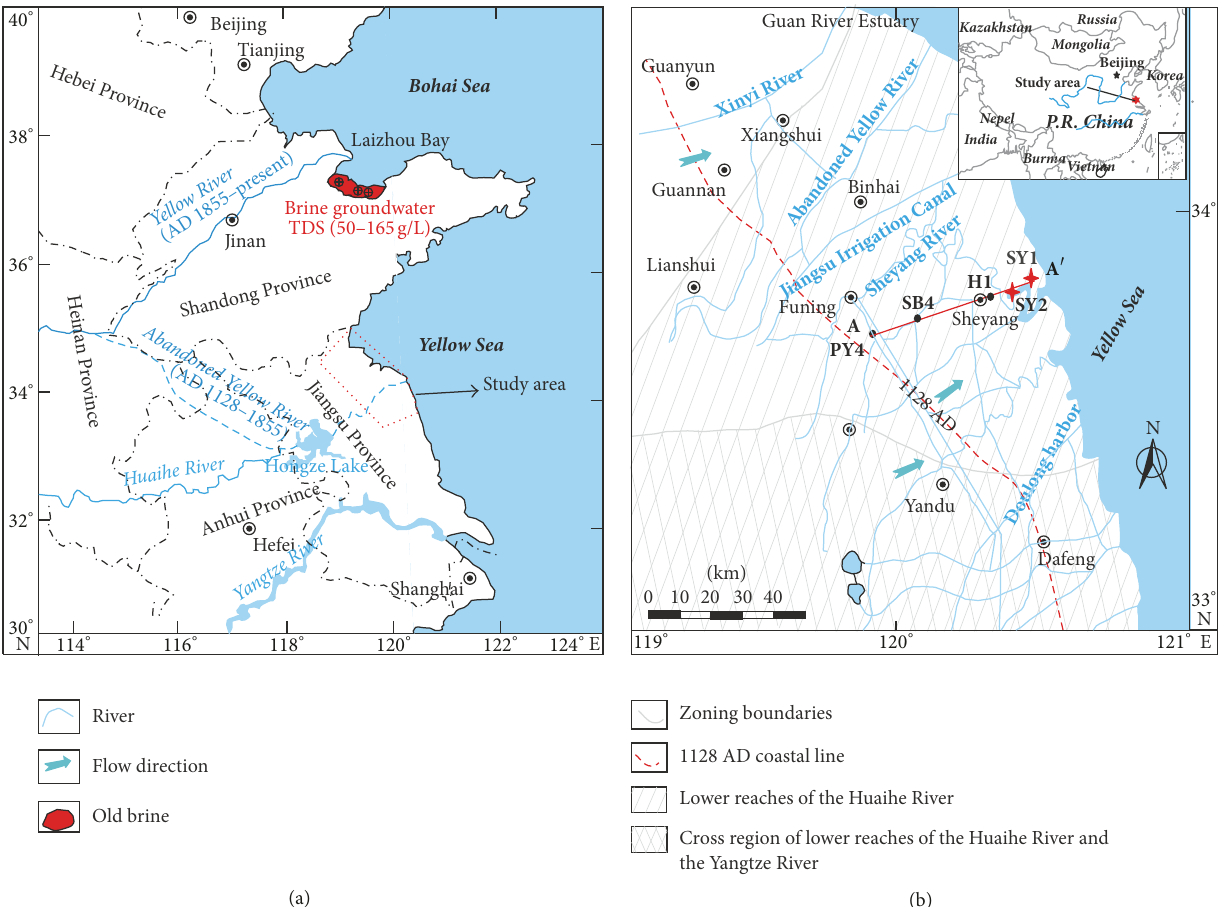
Figure 1: Location map of the research area. The A-A 󸀠 line indicates the location of the cross-section displayed in Figure 2.